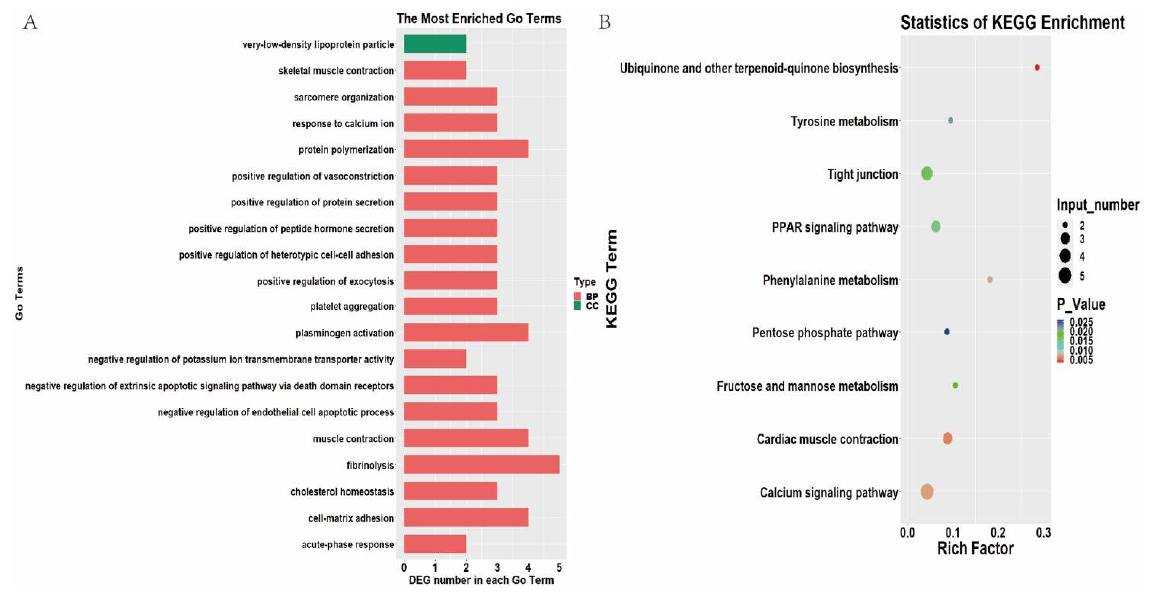
Figure 5. GO and KEGG enrichment of differentially expressed genes (DEGs) between 66 and 35 weeks. ( A ). Top 20 GO terms of DEGs between 66 and 35 weeks. ( B ). Enriched KEGG pathway of DEGs between 66 and 35